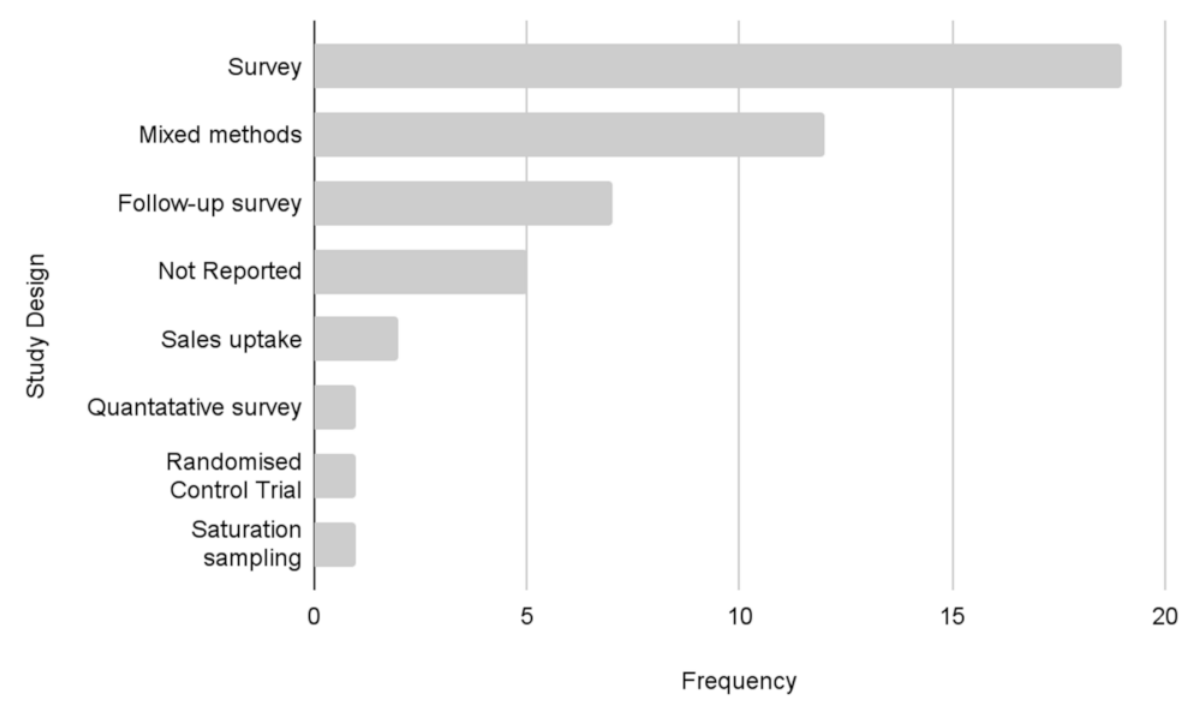
Figure 6. Study design and data collection